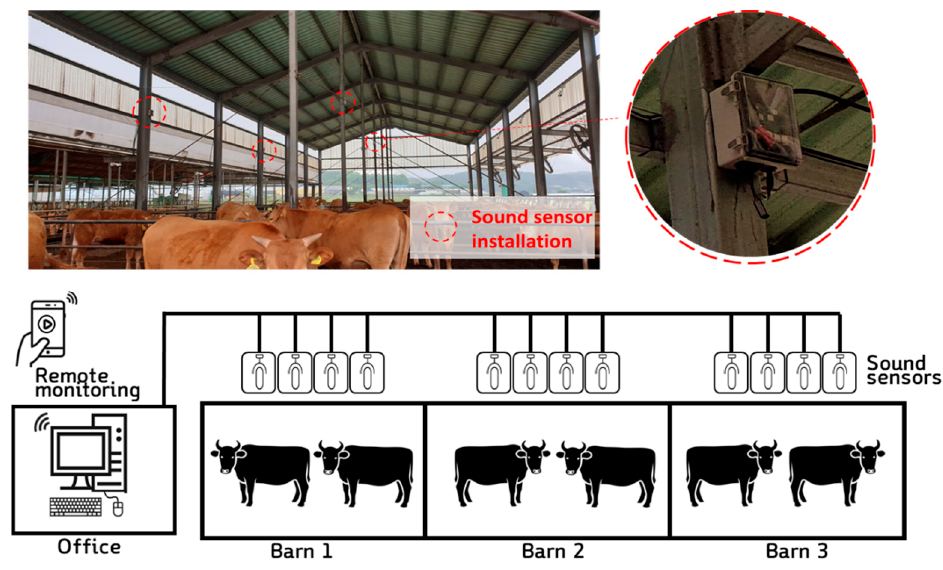
Figure 1. The installed vocal recording devices and web-based monitoring system.